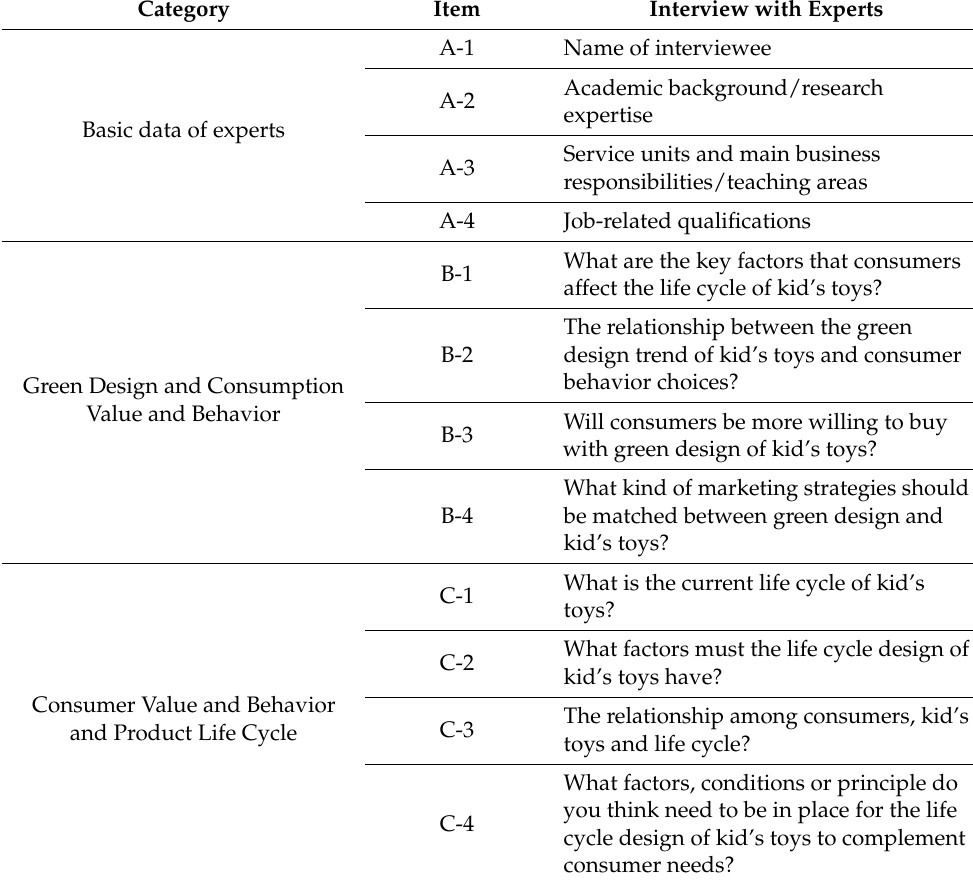
Table 2. Outline of the expert